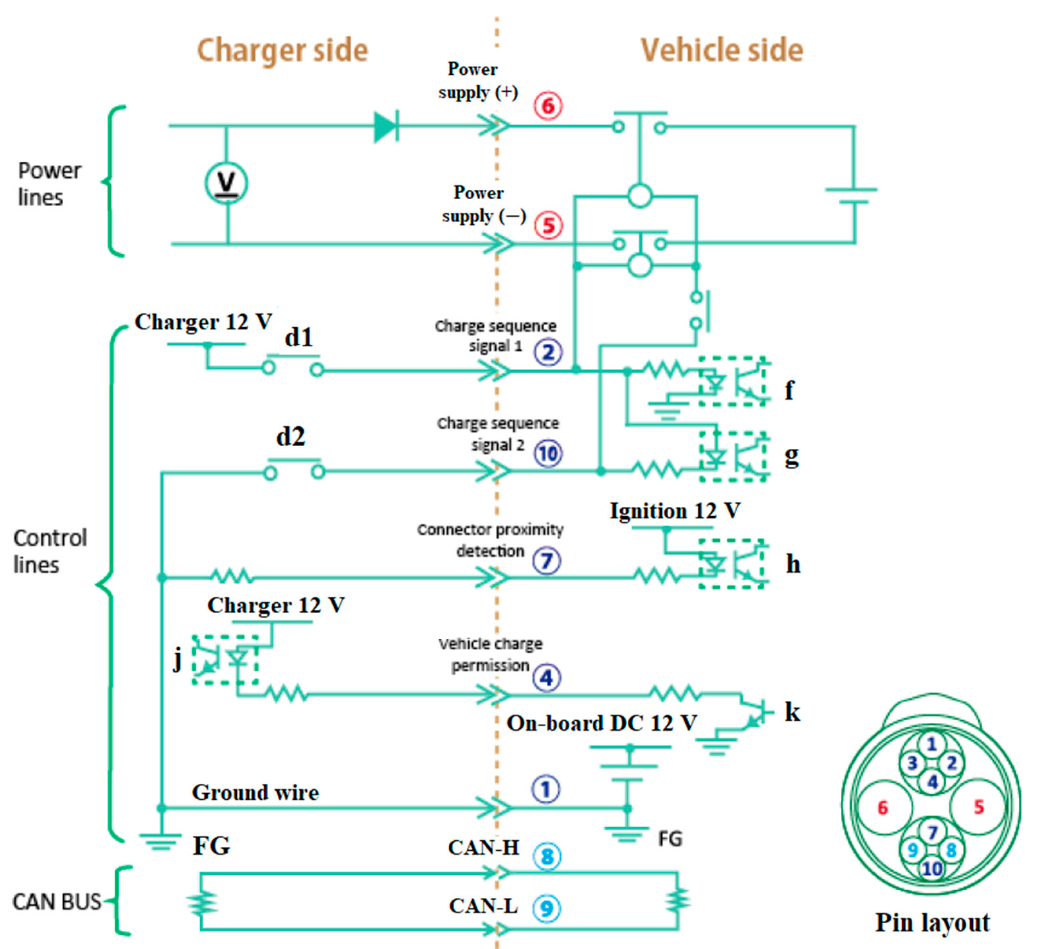
Figure 18. CHAdeMO sequence circuit and pin layout.